Question: Summarize what this figure shows in one sentence.
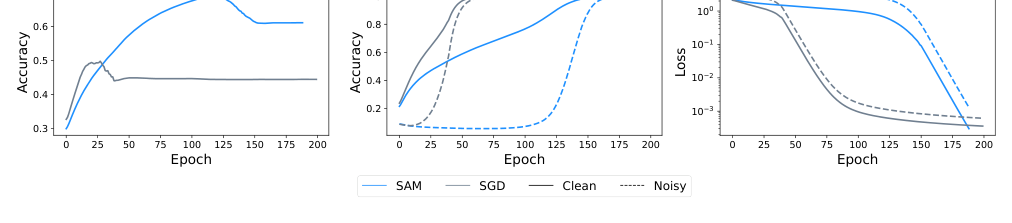
Answer: CIFAR10 training accuracy and loss in clean versus noisy data. SAM achives a higher clean training accuracy before fitting the noisy data, i.e., when accuracy of noisy training data surpasses random chance. This corresponds with a higher peak in test accuracy.